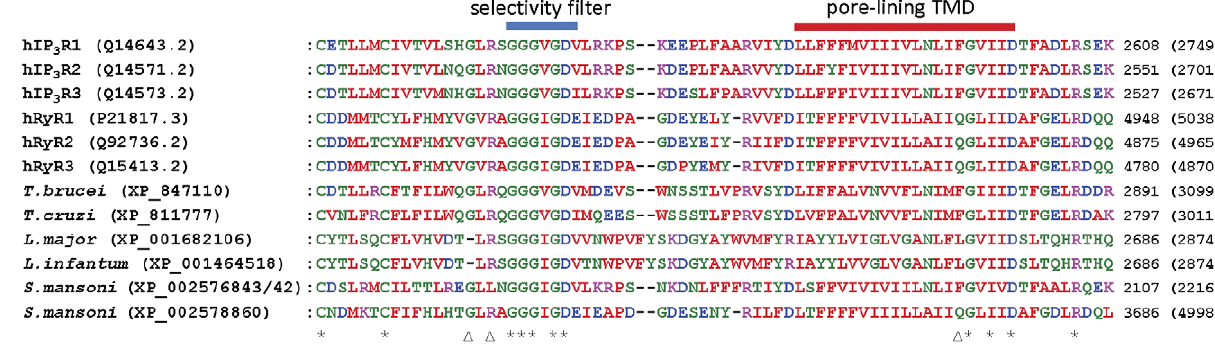
Figure 1. Alignment of parasite putative IP 3 Rs/RyRs with the pore regions of mammalian IP 3 Rs/RyRs. Alignments of the pore region of human IP 3 Rs and RyRs with putative homologues from T. brucei, T. cruzi, L. infantum, and S. mansoni . ClustalW2 physiochemical residue colours are shown, and protein accession numbers are shown in parentheses after the species name. Numbers in parentheses to the right of the alignments indicate the total number of residues in the protein. Asterisks below the alignment indicate absolute residue conservation in all homologues. Triangles below the alignment indicate the position of residues discussed in the text (G4891, R4893 and Q4934 of hRyR1). The blue bar above the alignment indicates the selectivity filter region, while the red bar indicates the pore-forming transmembrane domain (TMD). The S. mansoni protein labelled XP_002576843/42 is formed by concatenated XP_002576843 and XP_002576842 predicted proteins (whose genomic loci are adjacent). The entire concatamer was confirmed as a single intact protein by its identity with the predicted protein: 29191.m000804.twinscan2 (Wellcome Trust Sanger Institute, UK).